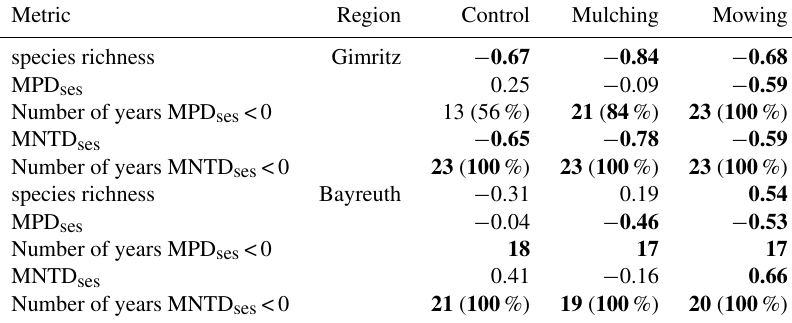
Table 2. Spearman rank correlations of the metrics species richness, effect size of mean pairwise phylogenetic distance (MPD ses ) as well as effect size of mean nearest taxon distance (MNTD ses ) versus years since start of the succession. For each year and region, we used the mean of the metrics across subplots. Significant values ( p <0.05) are in bold. Note that because of the temporal autocorrelation these significance values are not strictly valid. For mean MPD ses and MNTD ses we also give the number of years in which the mean values were smaller than 0, therefore indicating that the species co-occurring within subplots are phylogenetically more related than expected by chance ( = clustered). If species composition is random in respect to phylogenetic relatedness we would expect that half of the mean values are <0 and half of the values >0. In our case all values were <0. Using the binomial distribution such a result is significant. Metric Region Control Mulching Mowing species richness Gimritz